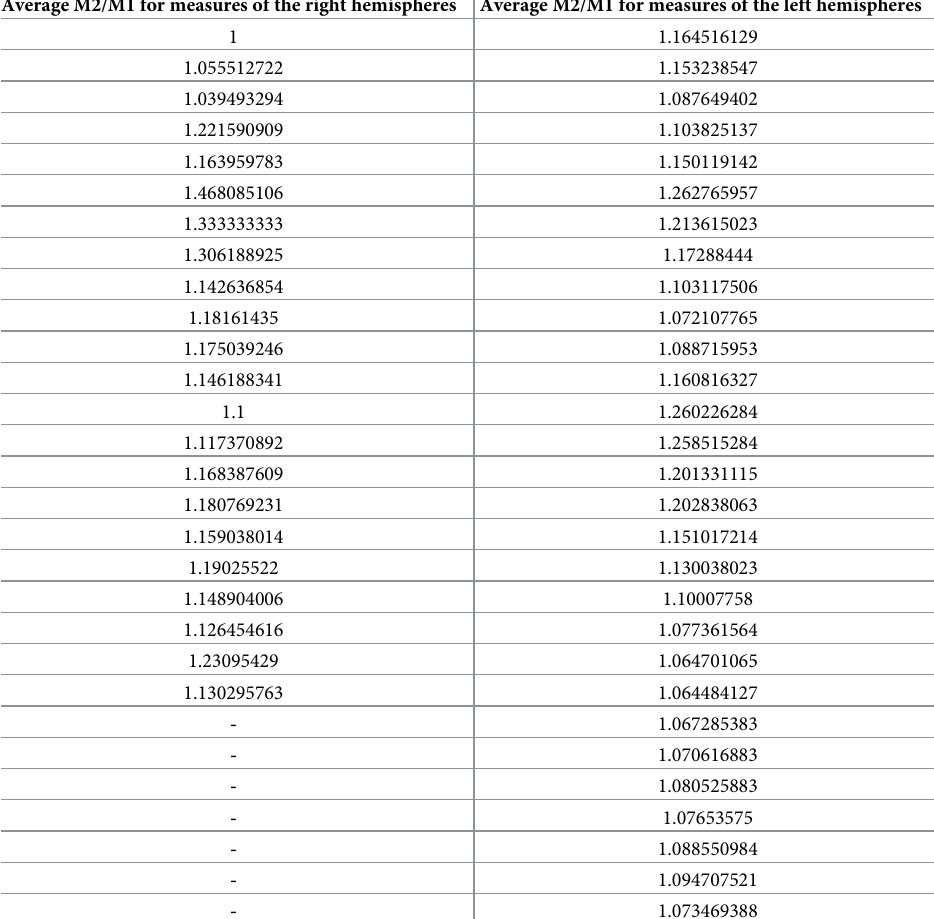
Table 2. Raw data for the M2/M1 ratio of hemispheres of Sapajus . Absent data are due to problems with obtaining reliable data from photos. Average M2/M1 for measures of the right hemispheres Average M2/M1 for measures of the left hemispheres 1